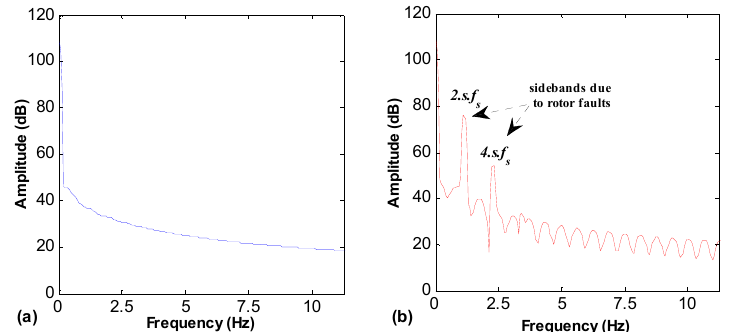
Figure 5. Park’s vector spectrum: ( a ) healthy motor and ( b ) motor with simulated BRB.